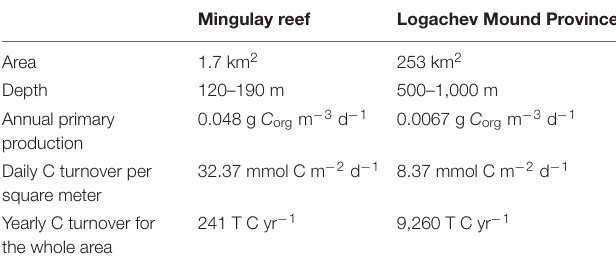
The reported values of carbon (C) turnover are the mean values. The total C turnover at the Mingulay Reef is based on data from live Lophelia pertusa, the sponge Spongosorites coralliophaga and Aquatic Eddy-Correlation (AEC) data of the dead framework. The AEC measurements capture the oxygen consumption of the dead framework and baffled sediment community. The results on C turnover for Logachev include data of live and dead L. pertusa, sediments and baffled sediments (see Section “Oxygen Consumption and Nitrogen